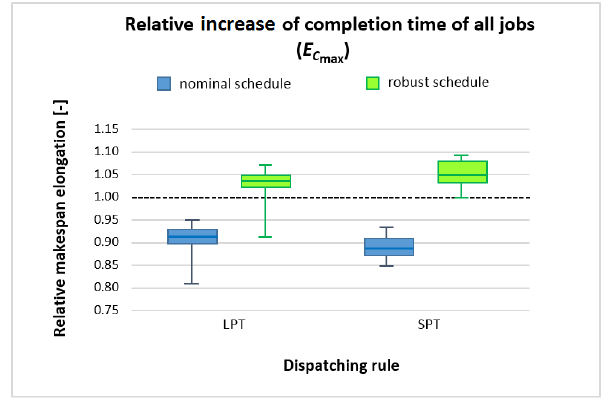
Figure 4. Relative increase of makespan in LPT and SPT schedules.